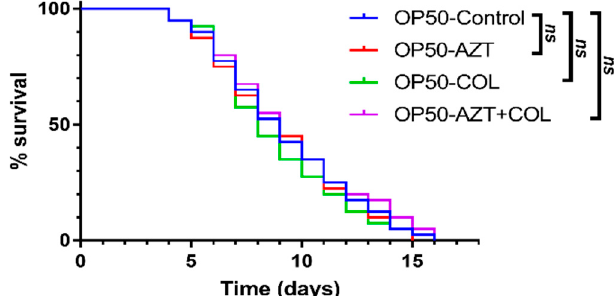
Figure 3. In vivo toxicity testing of colistin, AZT, or colistin / AZT combination using a C. elegans model. Nematodes (n = 40, each group) were fed with nontoxic E. coli laboratory strain OP50 and supplemented with a vehicle (control), colistin (COL, at 1 µ g / mL), azidothymidine (AZT, at 0.15 µ g / mL), or a combination (AZT + COL, at 0.15 / 1 µ g / mL). ns, no significance.